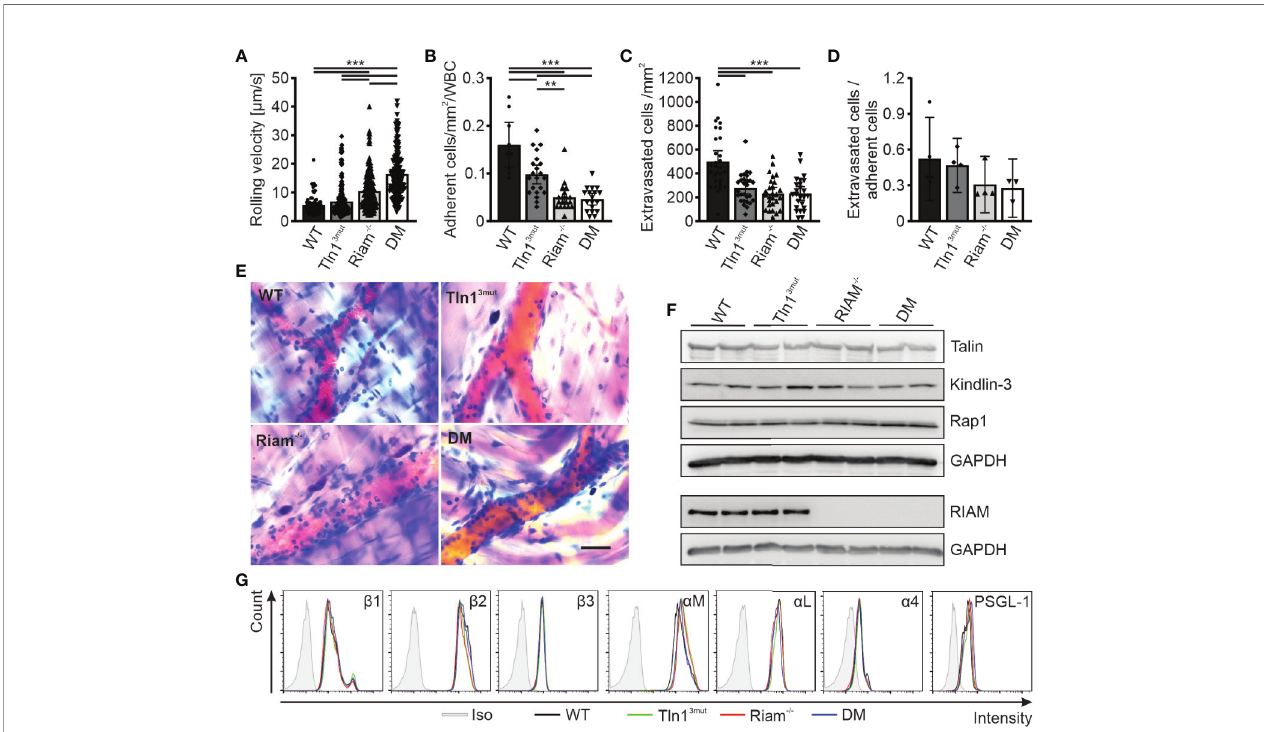
FIGURE 2 | Neutrophil rolling, adhesion and extravasation are impaired when the Rap1/talin and Rap1/Riam/talin pathways are blocked. (A – E) In vivo leukocyte rolling velocity (A) , adhesion ef fi ciency (B) , extravasation (C) and extravasation ef fi ciency (D) analyzed in cremaster muscle venules of WT, Tln1 3mut , Riam -/- and DM mice 2 h after intrascrotal TNF a injection. Rolling velocity and adhesion ef fi ciency were assessed using intravital microscopy. Extravasation was analyzed by counting the number of perivascular cells in Giemsa stained cremaster muscle whole mounts (N = 3-6 vessels per mouse in 2/4/4/4 mice, 5/4/4/4 mice for D ). (E) Representative images of Giemsa stained cremaster muscle whole mounts, scale bar: 30 µm. (F) Analysis of talin, kindlin-3, Rap1 and Riam expression in WT, Tln1 3mut , Riam -/- and DM neutrophils by western blot. GAPDH was used as loading control. (G) Integrin b 1, b 2, b 3, a M, a L and a 4 as well as PSGL-1 and L- Selectin surface levels on WT, Tln1 3mut , Riam -/- and DM neutrophils assessed by FACS analysis. Values represent mean ± 95% con fi dence interval. Statistical signi fi cance was assessed using One-way ANOVA followed by Tukey ’ s multiple comparison test. **p < 0.01, ***p <